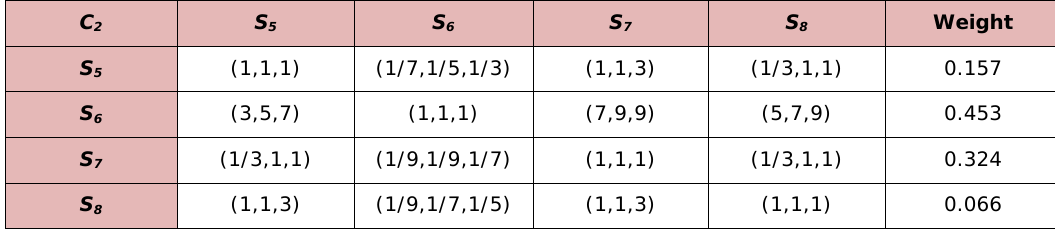
Table 4. “Fuzzy comparison matrix of the sub-criteria with respect to system